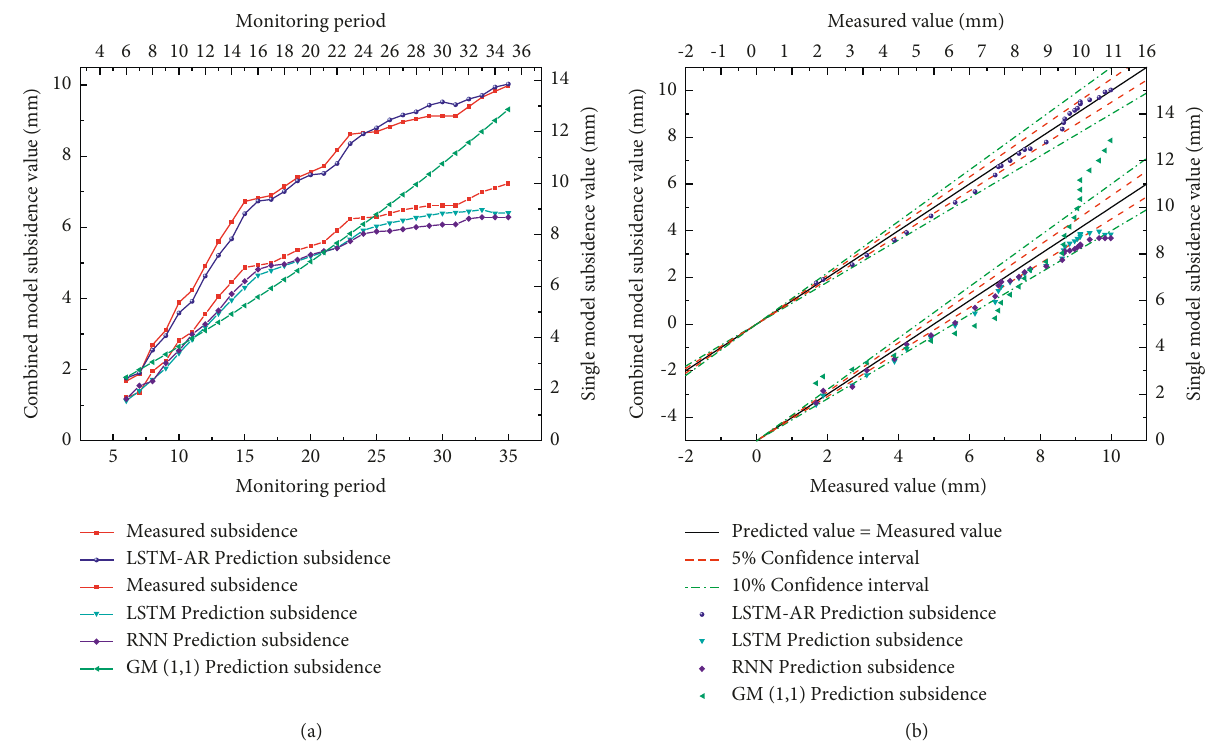
Figure 6: Comparison of prediction results of different models of